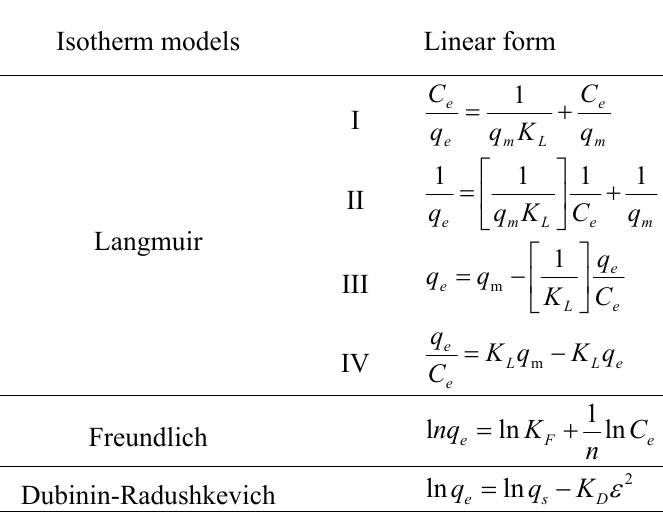
Table 2. Linear forms of the isotherm